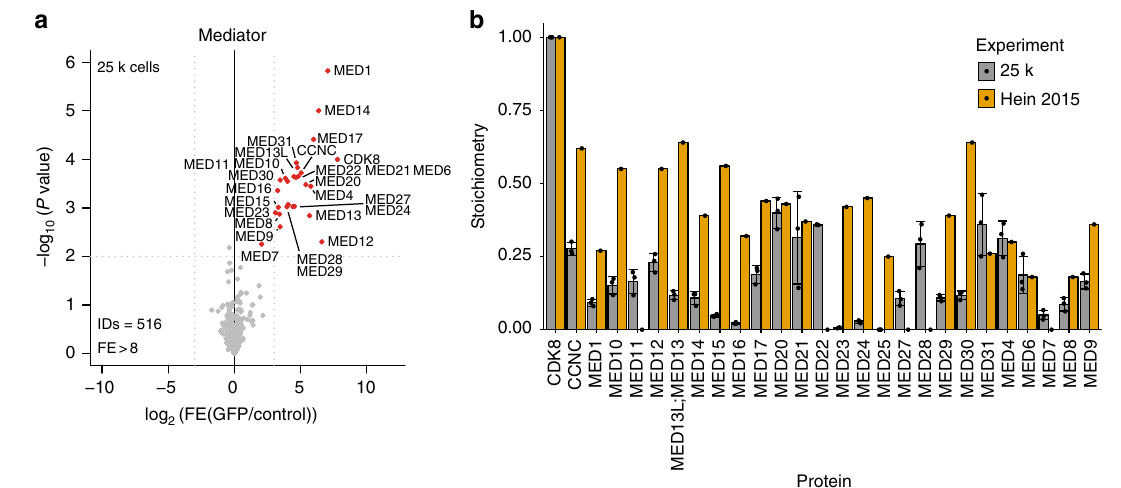
Fig. 3 Benchmark of on-chip AP-MS with Mediator complex. a Volcano plot from label-free micro fl uidic pull-down for CDK8-GFP bait using 25,000 cells. Dotted gray lines represent statistical cut-offs. Black dots identify signi fi cant proteins; red dots are used for known interactors of the bait. ID refers to the total number of proteins reported and FE stands for fold enrichment. The volcano plot presents n = 1 biologically independent experiment, each comprised of n = 3 technical replicates for PI-GFP and control extract. b Stoichiometry of the mediator subunits as compared to CDK8 for the experiments using the same pull-down performed by Hein et al. 10 as reference. iBAQ values for each of the interaction partners of Mediator complex were divided by the iBAQ values of the bait (CDK8, set to 1). Data display mean values ± s.d. Gray fi lled bars are used for representing the Mediator complex stoichiometry as obtained by the 25,000 cells input experiment while yellow bars describe the stoichiometry for Mediator obtained by the microcentrifuge tube-based pull- down performed by Hein et al. 10 . Black dots represent the individual data points. Source data are provided as a Source Data fi le